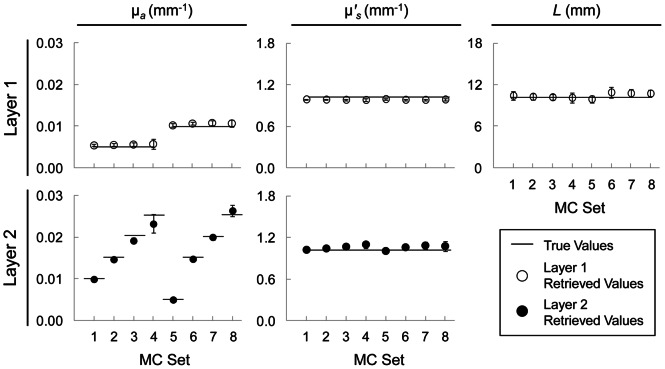
Six-parameter fitting procedure results on eight sets of two-layered Monte Carlo (MC) simulations reported in terms of MC set.
True values represent values used for µa (column 1), µ′s (column 2), and first layer thickness (column 3) in each MC simulation. Retrieved values for Layer 1 (row 1) and Layer 2 (row 2) are represented by open and filled circles, respectively. The error bars represent uncertainties determined by the fitting procedure.